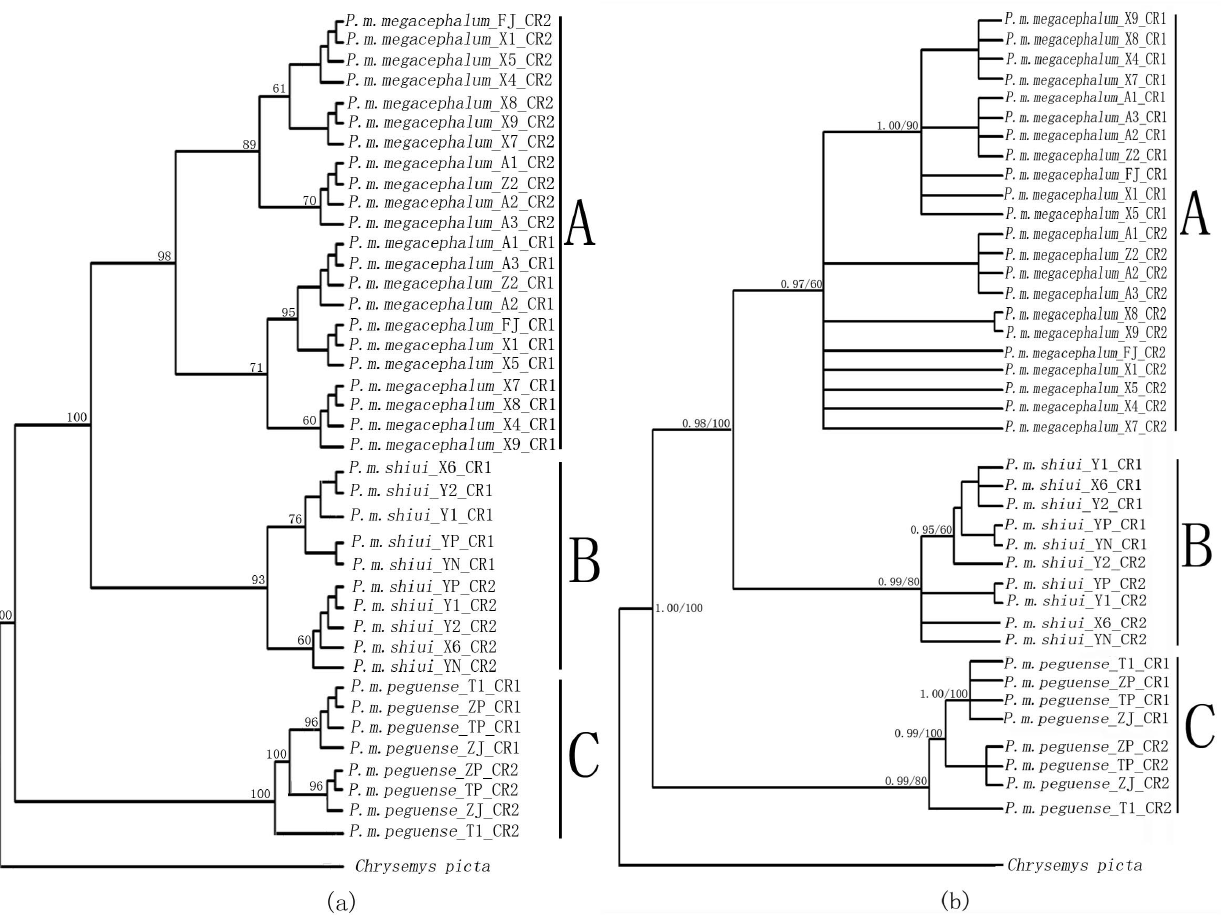
Figure 4. Phylogenetic trees reconstructed using (a) neighbor-joining, (b) maximum likelihood and Bayesian methods. Three clades were grouped. These contained the three subspecies of Platysternon megacephalum : (A) P.m. megacephalum , (B) P.m. shiui , and (C) P.m. peguense . doi:10.1371/journal.pone.0082854.g004 PLOS ONE |